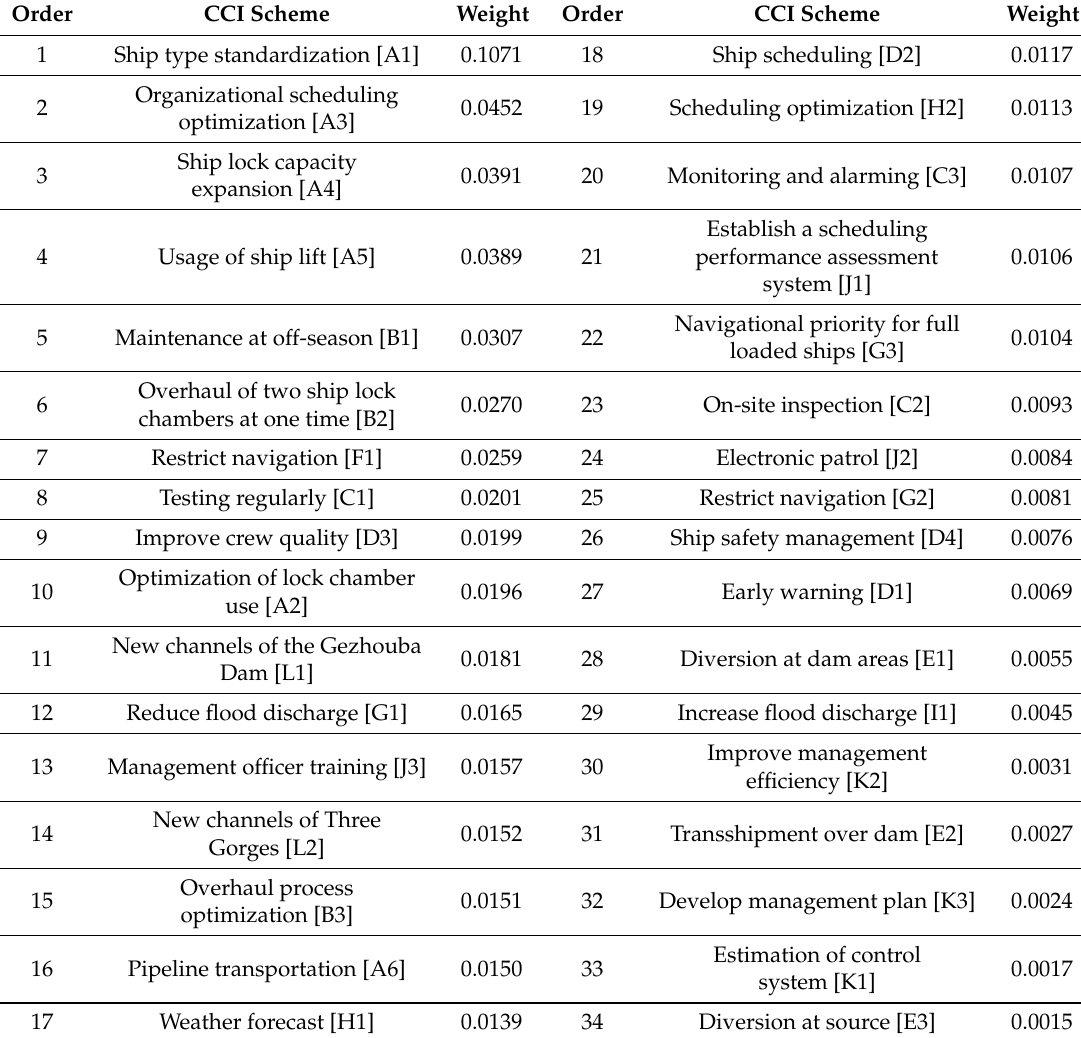
Table 9. Ranking of CCI schemes according to the